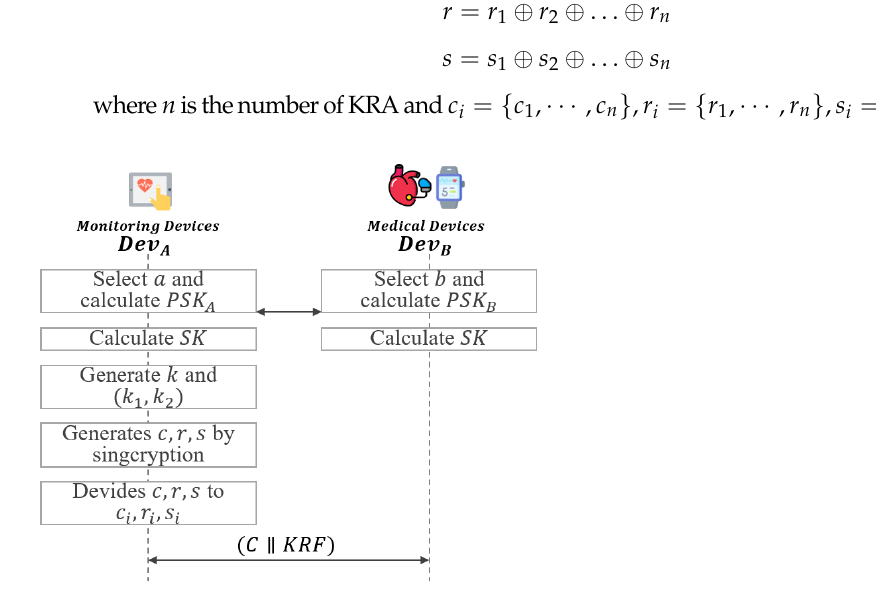
Figure 5. Session key exchange and encryption phase of proposed scheme-I.